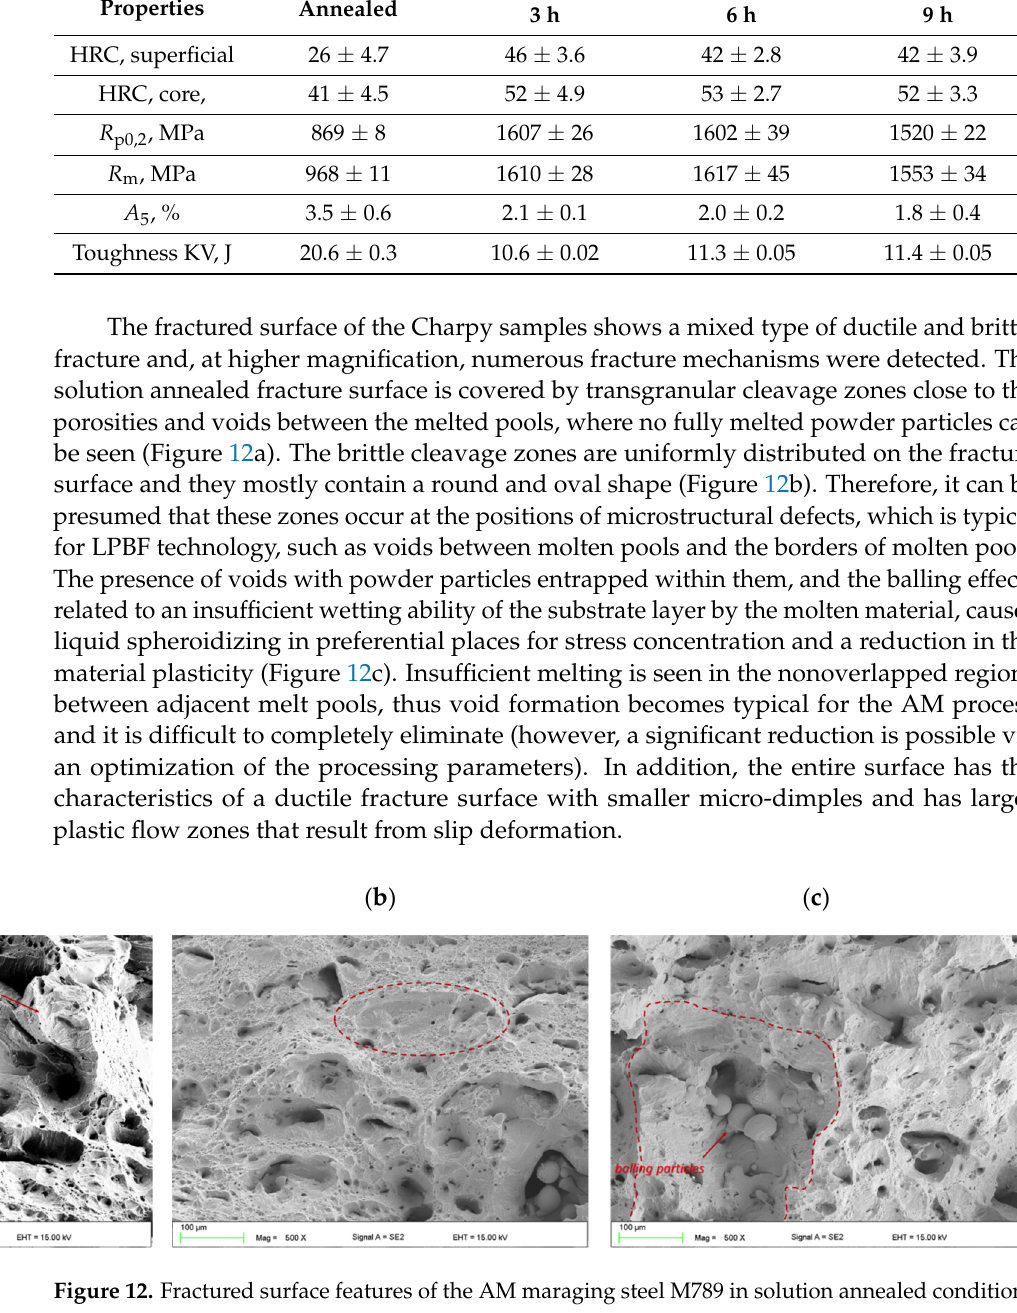
Figure 13. Fractured surface features of the AM maraging steel M789 in aging conditions: ( a ) 3 h, ( b ) 6 h and ( c ) 9 h . It should be emphasized that a commercial powder was used, without any prelim- inary preparation applied to it, alongside a subsequent baseline optimization of the